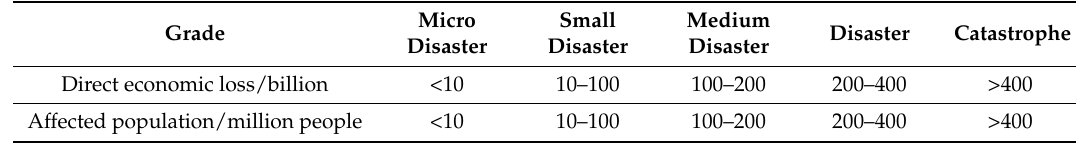
Table 4. Storm surge disaster intensity division based on disaster loss